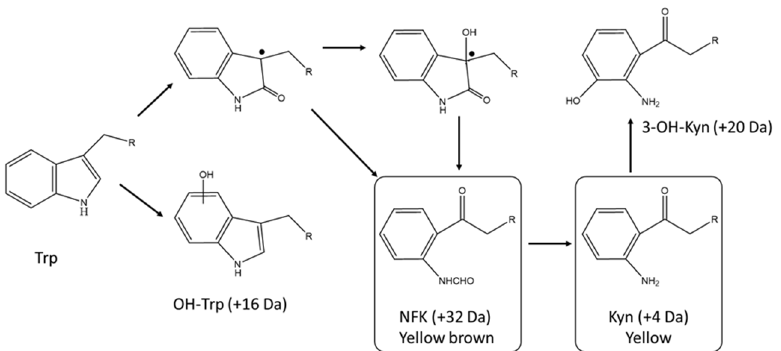
Figure 3. Tryptophan degradation pathways. Trp is for tryptophan, Kyn is for kynurenine, NFY is N-formylkynurenine, OH-trp and 3-OH-Kyn are for hydroxyl tryptophan and hydroxyl kynurenine, respectively. Changes in mass for each tryptophan degradation products are shown. Adapted from reference [6].